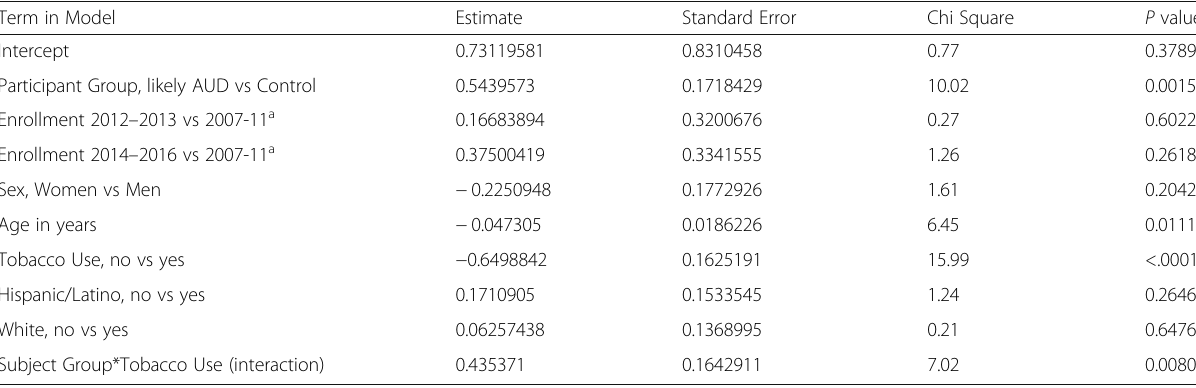
Table 2 Multiple logistic regression analysis to determine predictors of cannabis use among the entire cohort ( n = 303) Term in Model